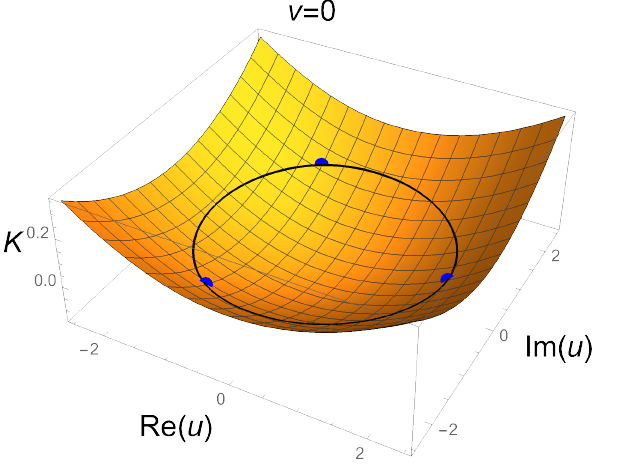
(b) K plotted in the complex u -plane, with v = 0 , evaluated on a grid with spacing δ Re u = δ Im u = 0 . 25 . The three multi-monopole points are indicated by blue dots. Figure 3. The SU(3) Kähler potential, plotted numerically on two-real-dimensional slices of the moduli space, using the method of appendix D.2. The K = 0 contours are depicted in